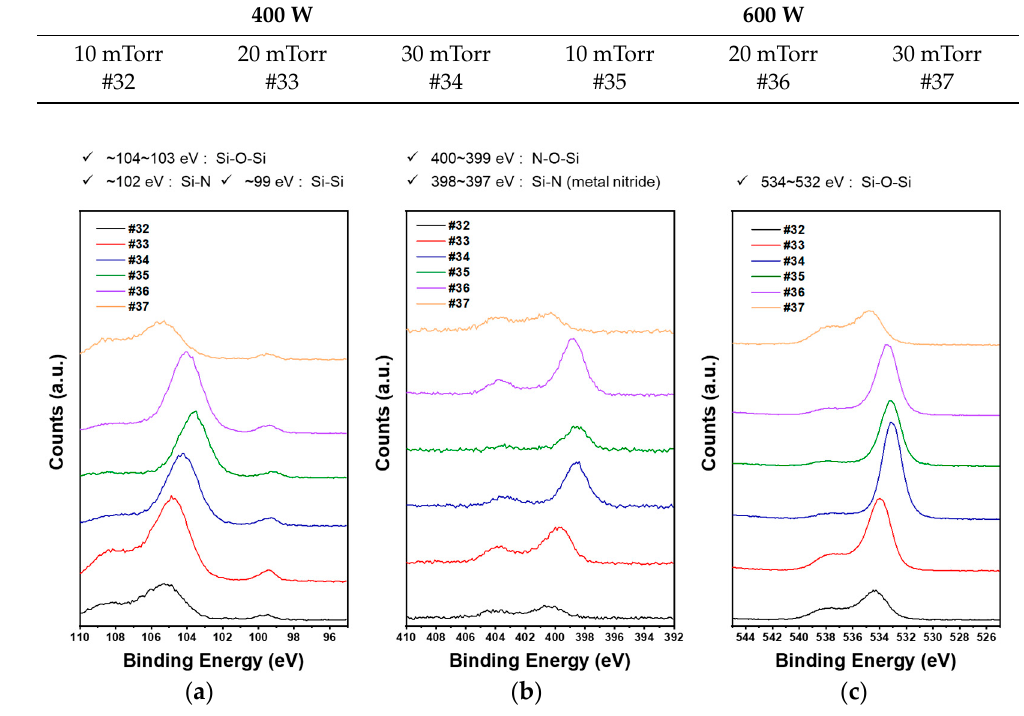
Figure 4. Ion density dependence on power: ( a ) N (cid:2870)(cid:2878) and ( b ) N (cid:2878) ion density. The nitrogen ion ( N 2+ and N + ) density increases as the source power increases; ac- cordingly, more energy is transferred to the plasma electrons, and the ionization rate in- creases, which in turn increases the nitrogen ion density. N + density tended to be much lower than N 2+ density because N + ions are generated by the dissociative ionization of N (cid:2870) as well as the dissociative excitation of N 2+ . As shown in Figure 4, the N (cid:2878) ion density increases with increasing pressure and power. However, the N 2+ density increases as the power increases but decreases as the pressure increases. N 2+ ions are the primary species in the nitrogen plasma that contribute to the nitridation of SiO 2 thin films. Table 1 presents the conditions of the measurements. Figure 5 shows the XPS profiles of the samples. Table 1. Experimental conditions for XPS measurements. (# : Experimental number)